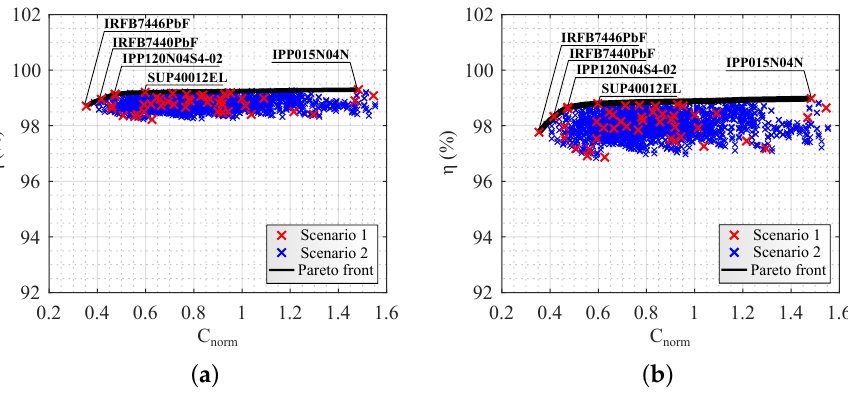
The Pareto front for DSPLS modulation is shown in Figure 11. The points in red represent the designs corresponding to scenario 1, and the points in blue represent the designs for scenario 2.